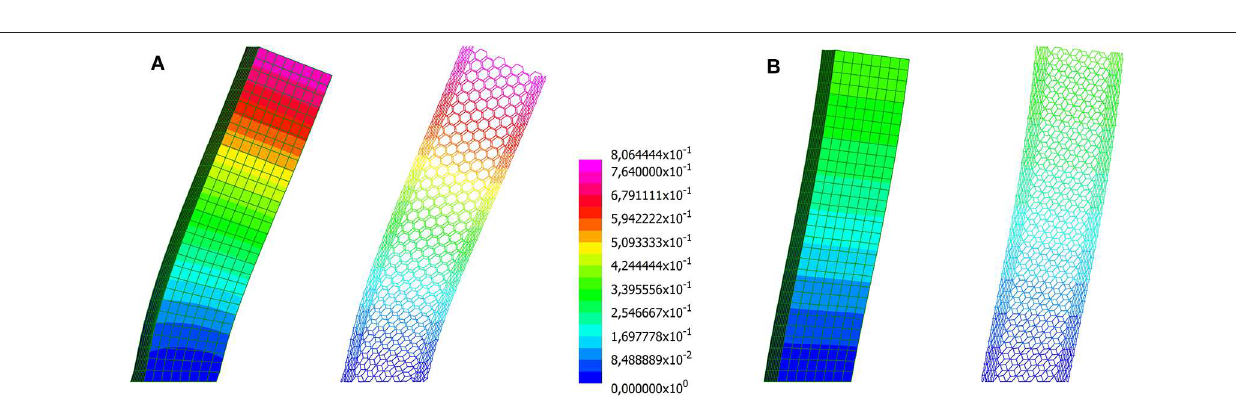
FIGURE 6 | Building with square plan employing a hexagrid with constant cross-section. Magnified deformed shapes computed through the multiscale approach and a beam model: (A) neglecting the contribution of the floors; (B) assuming rigid diaphragms (displacements in